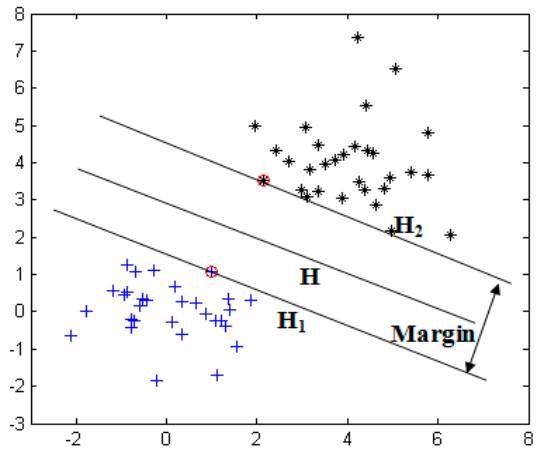
Figure 9. Linear SVM classification.